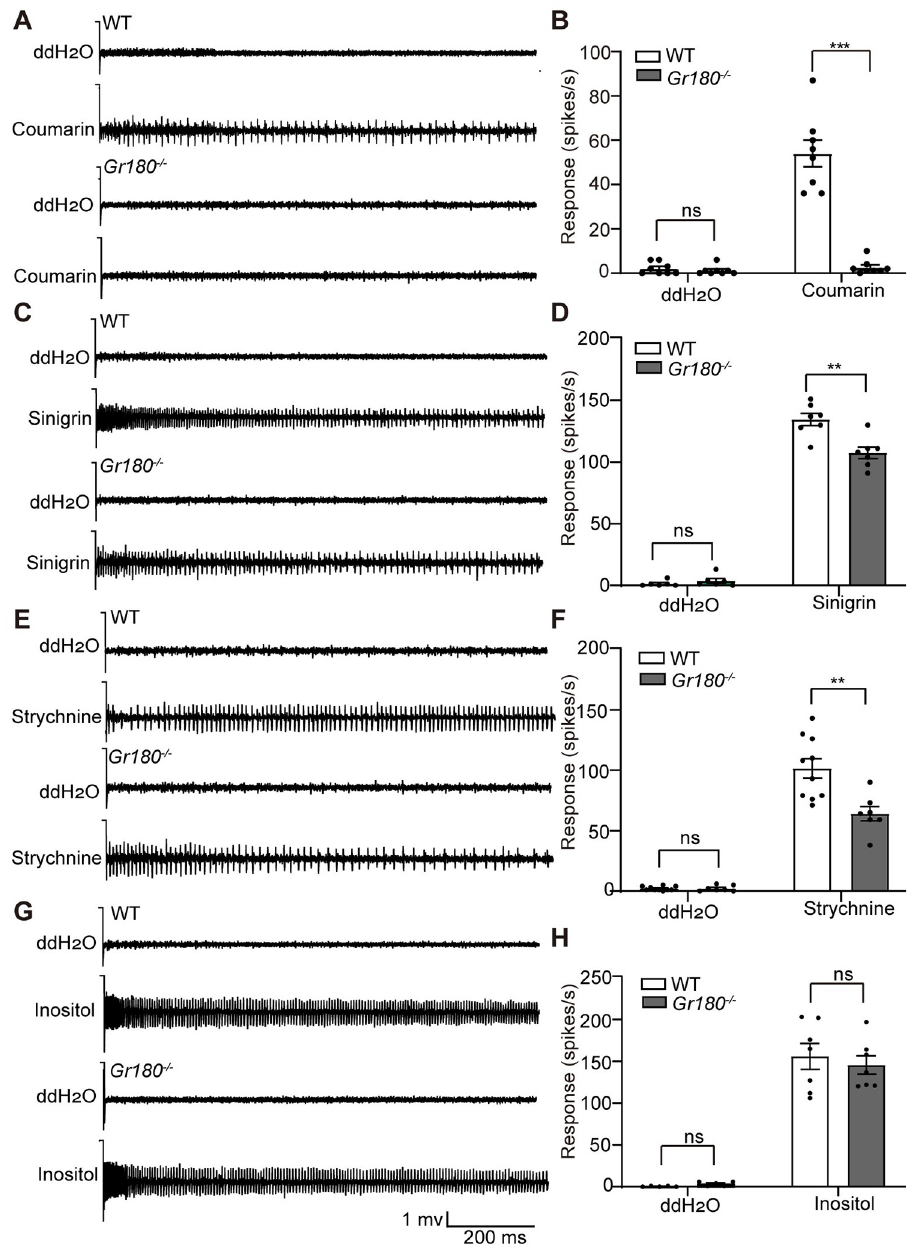
Fig 6. Electrophysiological responses of medial sensilla styloconica in larvae of Helicoverpa armigera wild type (WT) and Gr180 −/− mutants. Representative responses ( A , C , E , G ) and spike frequencies ( B , D , F , H ) of medial sensilla styloconica to 10 − 2 M coumarin (A, B), 10 − 2 M sinigrin ( C , D ), 10 − 2 M strychnine ( E , F ), 10 − 3 M inositol ( G , H ). Data are mean ± SEM, n = 7–11. �� and ��� indicate significant differences at the level of p < 0.01 and p < 0.001, respectively; ns indicates no significant difference (p > 0.05) (two-tailed independent